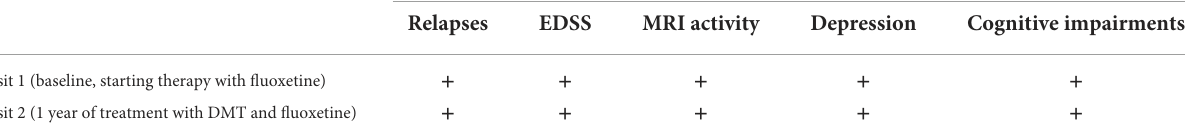
TABLE 1 The number of clinical visits and evaluated characteristics. Visit,